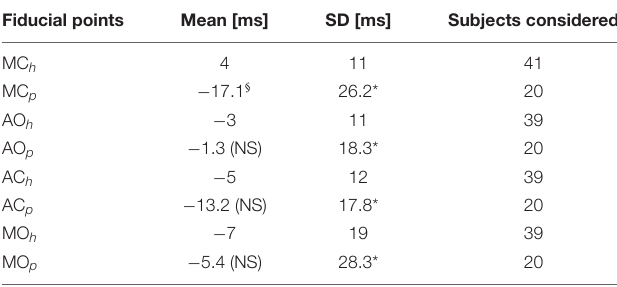
TABLE 5 | Mean and SD of Echo-FP differences in our 20 patients ( p subscript) and in the reference healthy subject dataset ( h